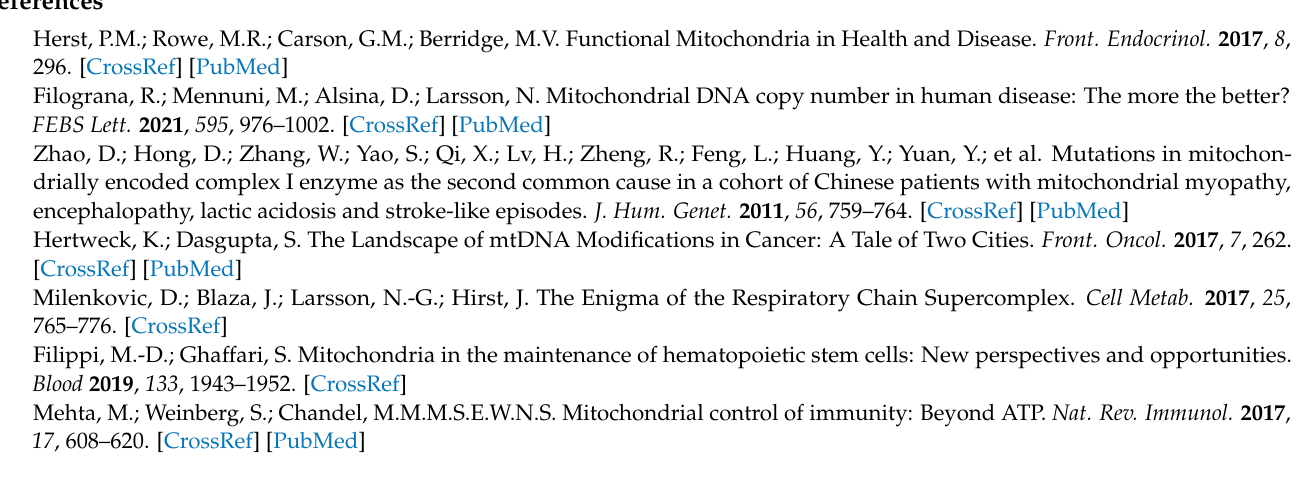
Figure S3: CMC graph of PEI–DQA (25 kDa) and PEI–DQA (10 kDa); Figure S4: Confocal microscopy study of the transfection of HeLa cells with PEI–DQA (10 kDa)/TAT/pND1 complexes at an N/P ratio of 20:2:1; Figure S5: Confocal microscopy study of the transfection of HeLa cells with